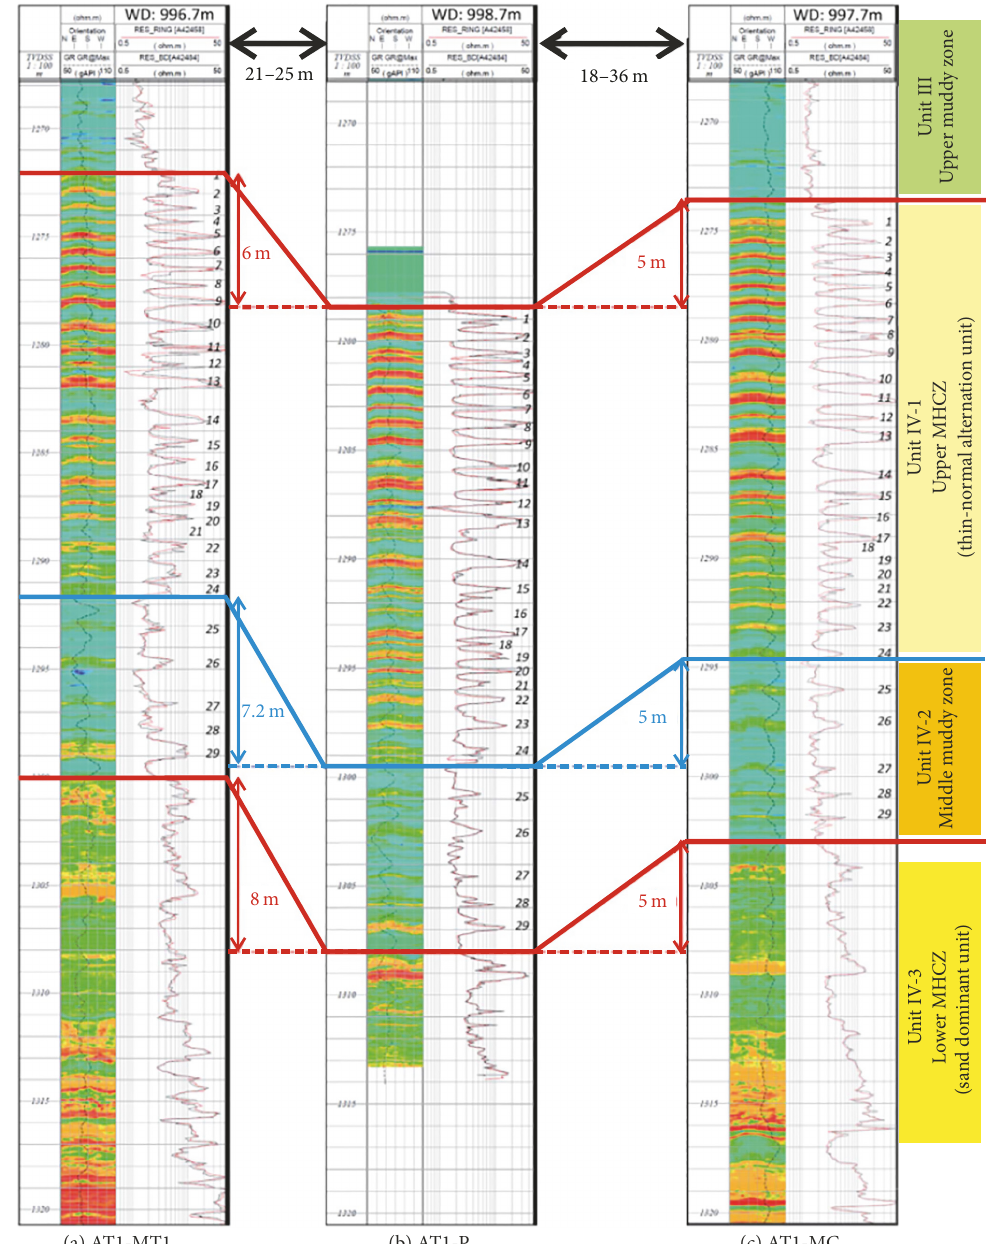
Figure 2: Resistivity images of three wells AT1-P, MT1, and MC at the AT1 site. The red color indicates the highly methane hydrate saturation sandy layers. The resistivity image logging indicated the stratum at the AT1 site with a dip angle approximately 20 ∘ ; thus, well AT1-P was located slightly down-dip from wells AT1-MC and MT1 [22,